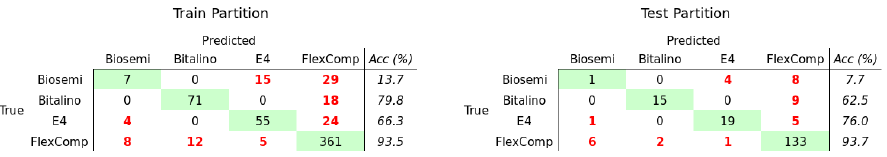
Figure 4. Confusion Matrices that show the result of the classification of the type of device, on the train ( left ) and test ( right ) partitions. On the diagonal (green), the numbers of correctly classified samples for each type of device. Out of the diagonal, in red, the numbers of mis-classified